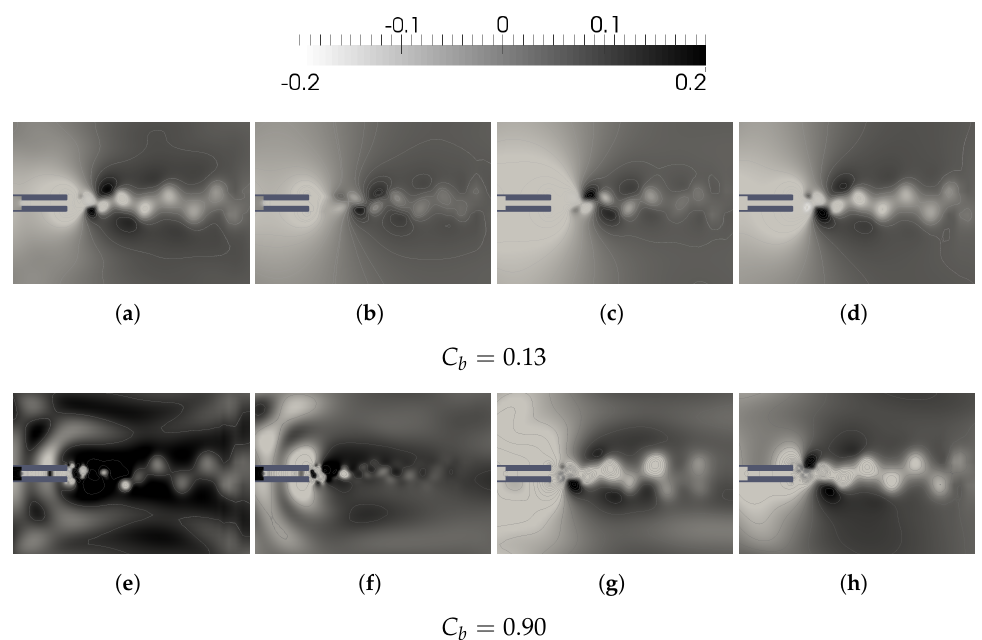
Figure 6. Snapshots of instantaneous pressure coefficient contours for a pulsating base bleed of f = 100 Hz and non-dimensional base bleed rates of C b = 0.13 and C b = 0.90. ( a ) t = 0.1 T . ( b ) t = 0.4 T . ( c ) t = 0.7 T . ( d ) t = T . ( e ) t = 0.1 T . ( f ) t = 0.4 T . ( g ) t = 0.7 T . ( h ) t = T